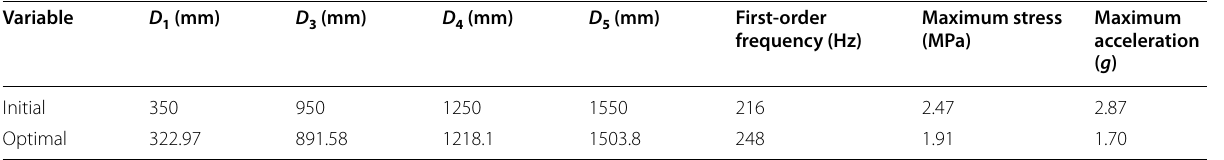
Table 5 Calculation results before and after optimization Variable